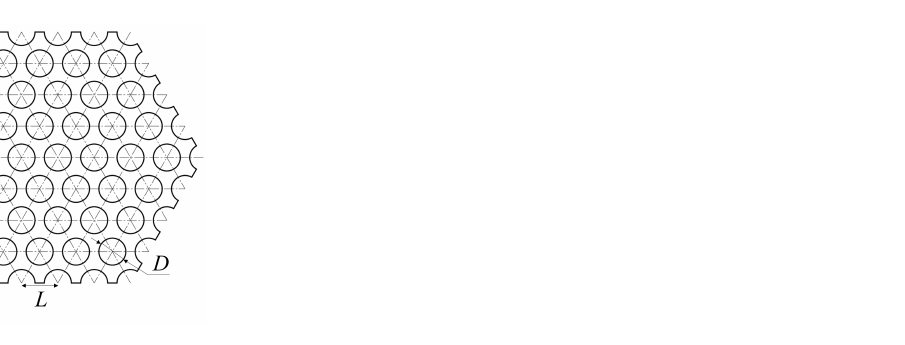
Figure 2. Shape of the checker brick. D is the hole diameter, and L is the distance between the holes.